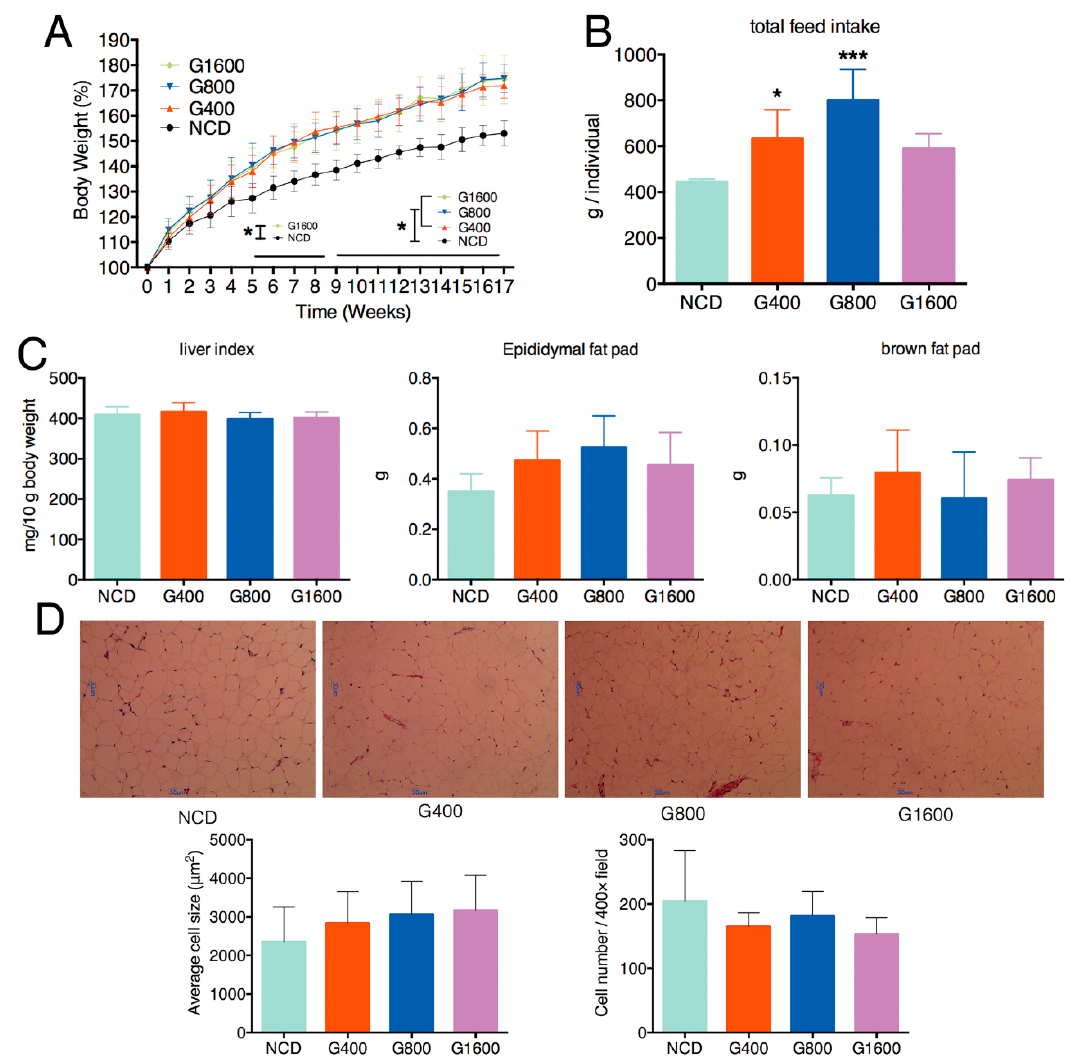
Figure 1. Effect of intake of different doses of GML on the ( A ) body weight, which expressed as a percentage compared to the initial body weight defined as 100%, ( B ) total food intake and ( C ) the liver indices, epididymal fat pad and brown fat pad of mice. ( D ) H&E staining of the epididymal adipose tissue ( n = 6, magnification: 100 × ). Data were means ± SD; * p < 0.05, *** p < 0.001 compared with the NCD group.